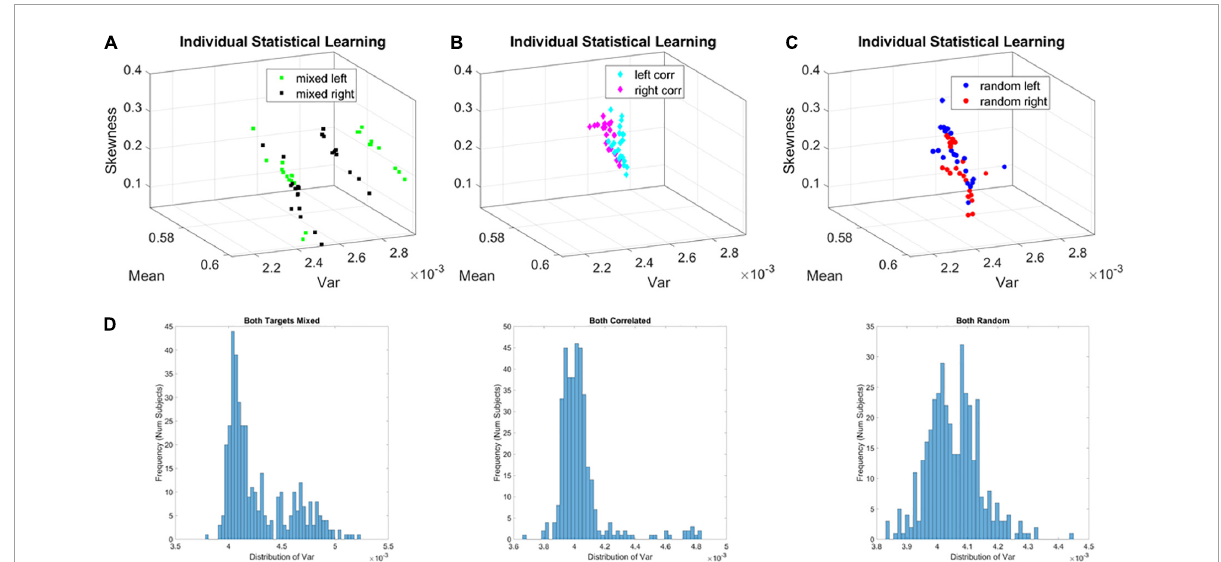
FIGURE5 Local learning evolution captures two classes of learners in the unstable environment (i.e., mixed group). Empirically estimated Gamma moments span a parameter space whereby each participant represents a point by the moments of the probability distribution. The coordinates are the mean ( x-axis ), the variance ( y-axis ), the skewness ( z-axis ). The color represents the target orientation (left or right). (A) Mixed case (i.e., group) whereby trials intermix random and correlated conditions, spanning a relatively unstable learning environment. In this group two self-emerging distinct subgroups of participants. (B) Correlated group, for which layouts are consistent from trial to trial, spanning a stable learning environment. (C) Random group, for which layouts are generated randomly from trial to trial, spanning a stable learning environment where no regularity is present. (D) Corresponding frequency histograms of the distribution of the variance across trials, target types and